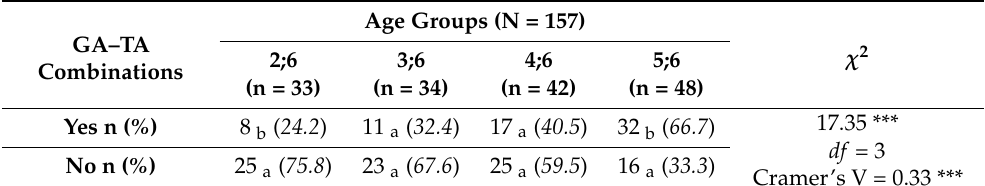
Table 5. Number of Children Producing Grammatical Aspect Markers (GA)–Temporal Adverb (TA) Combinations in all age Groups.